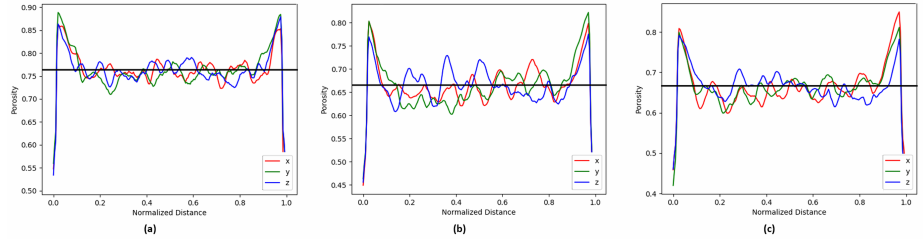
Figure 4. Total and local porosity for selected GDL samples: ( a ) fiber diameter of 6 µm, ( b ) fiber diameter of 8 µm, and ( c ) fiber diameter of 10 µm.